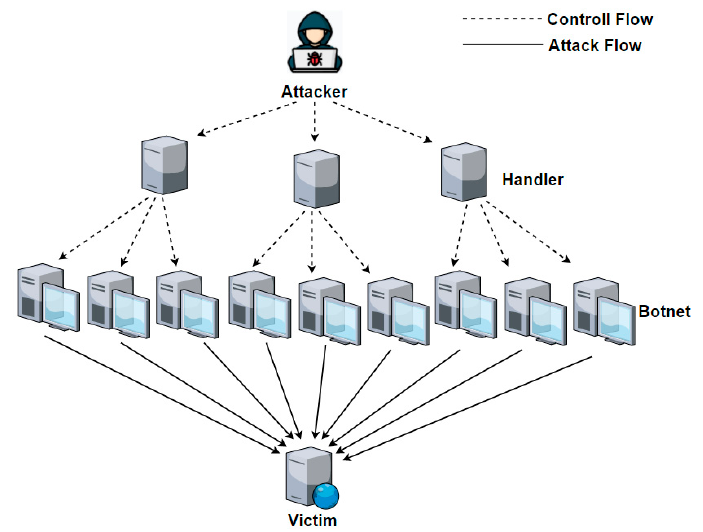
Figure 1. DDoS attack with a botnet.